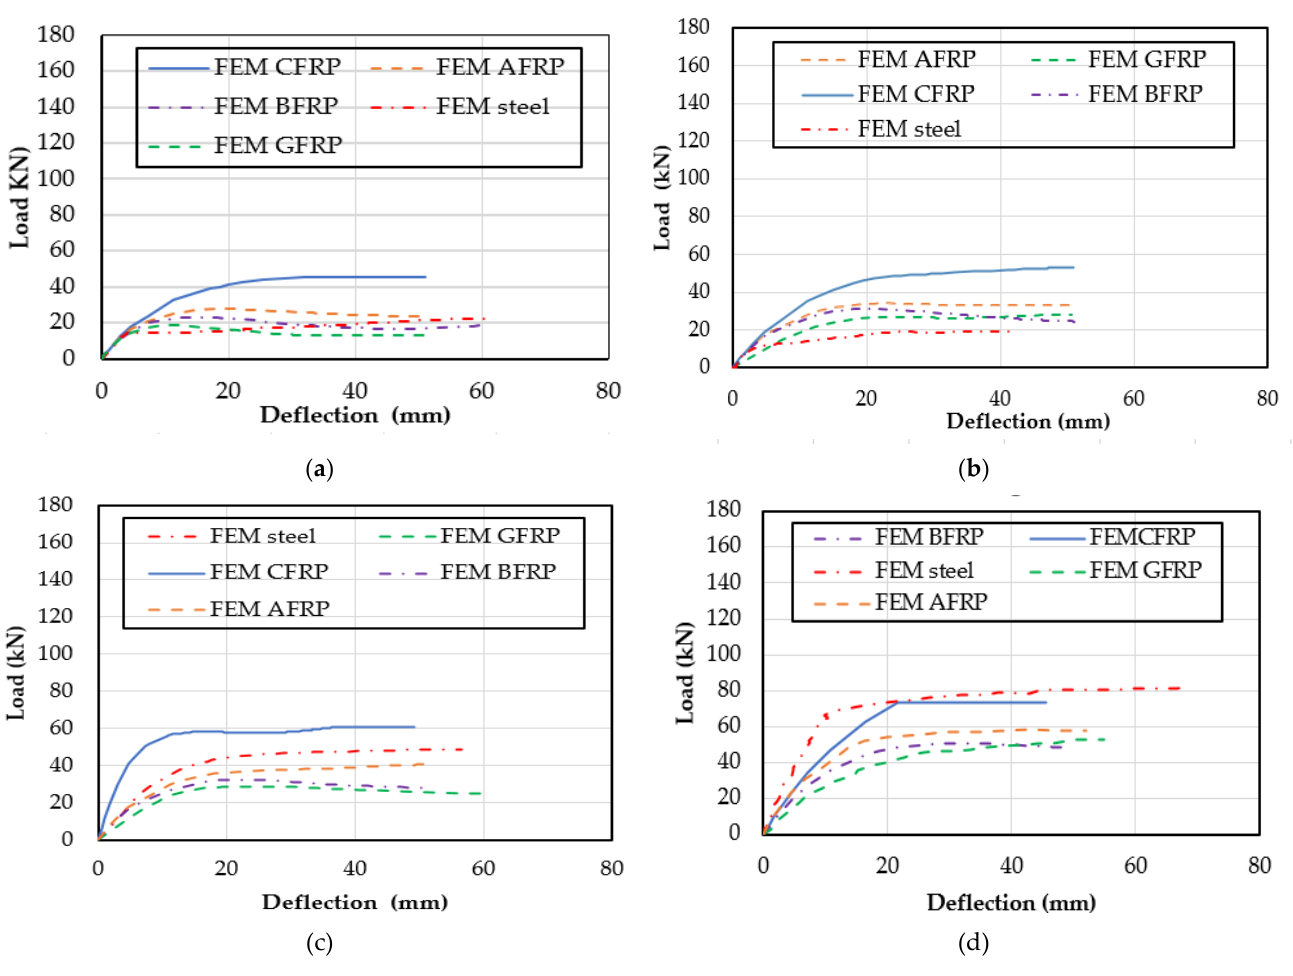
Figure 9. Load ‒ deflection relationship for different reinforcement ratios: ( a ) 0.15%, ( b ) 0.27%, ( c ) 0.42%, and ( d ) 0.60%.